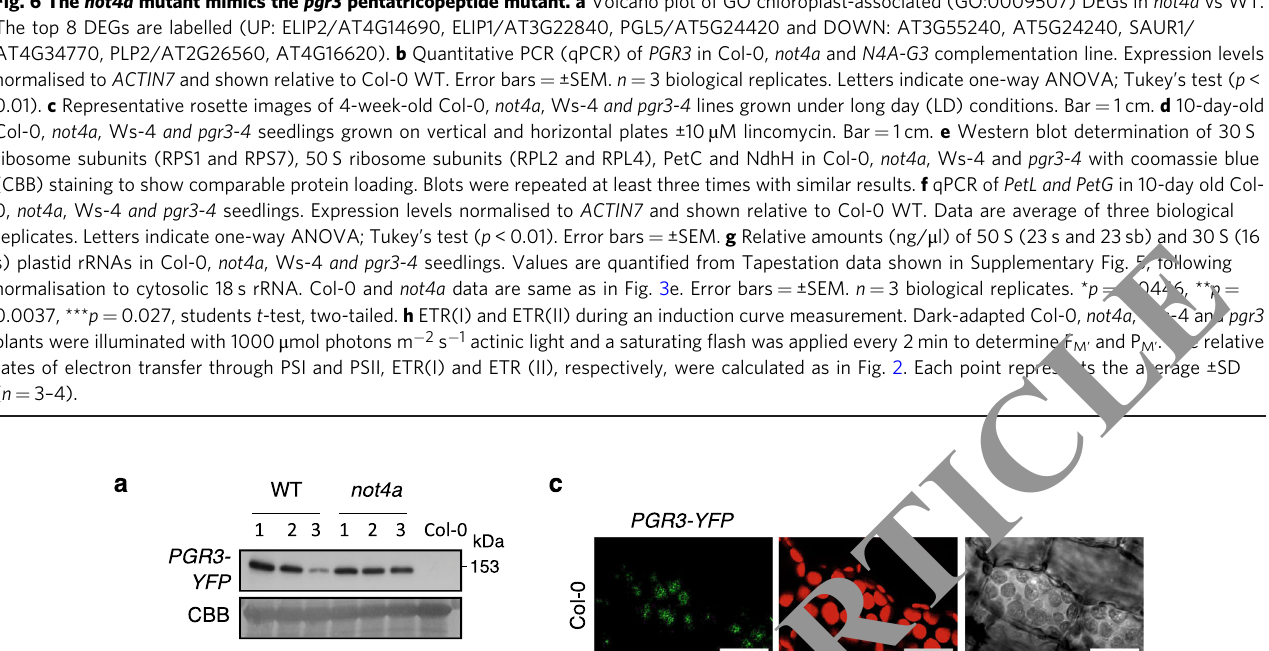
Fig. 6 The not4a mutant mimics the pgr3 pentatricopeptide mutant. a Volcano plot of GO chloroplast-associated (GO:0009507) DEGs in not4a vs WT. The top 8 DEGs are labelled (UP: ELIP2/AT4G14690, ELIP1/AT3G22840, PGL5/AT5G24420 and DOWN: AT3G55240, AT5G24240, SAUR1/ AT4G34770, PLP2/AT2G26560, AT4G16620). b Quantitative PCR (qPCR) of PGR3 in Col-0, not4a and N4A-G3 complementation line. Expression levels normalised to ACTIN7 and shown relative to Col-0 WT. Error bars = ±SEM. n = 3 biological replicates. Letters indicate one-way ANOVA; Tukey ’ s test ( p < 0.01). c Representative rosette images of 4-week-old Col-0, not4a , Ws-4 and pgr3-4 lines grown under long day (LD) conditions. Bar = 1 cm. d 10-day-old Col-0, not4a , Ws-4 and pgr3-4 seedlings grown on vertical and horizontal plates ±10 µ M lincomycin. Bar = 1 cm. e Western blot determination of 30 S ribosome subunits (RPS1 and RPS7), 50 S ribosome subunits (RPL2 and RPL4), PetC and NdhH in Col-0, not4a , Ws-4 and pgr3-4 with coomassie blue (CBB) staining to show comparable protein loading. Blots were repeated at least three times with similar results. f qPCR of PetL and PetG in 10-day old Col- 0, not4a , Ws-4 and pgr3-4 seedlings. Expression levels normalised to ACTIN7 and shown relative to Col-0 WT. Data are average of three biological replicates. Letters indicate one-way ANOVA; Tukey ’ s test ( p < 0.01). Error bars = ±SEM. g Relative amounts (ng/ μ l) of 50 S (23 s and 23 sb) and 30 S (16 s) plastid rRNAs in Col-0, not4a , Ws-4 and pgr3-4 seedlings. Values are quanti fi ed from Tapestation data shown in Supplementary Fig. 5, following normalisation to cytosolic 18 s rRNA. Col-0 and not4a data are same as in Fig. 3e. Error bars = ±SEM. n = 3 biological replicates. * p = 0.0446, ** p = 0.0037, *** p = 0.027, students t -test, two-tailed. h ETR(I) and ETR(II) during an induction curve measurement. Dark-adapted Col-0, not4a , Ws-4 and pgr3 plants were illuminated with 1000 μ mol photons m − 2 s − 1 actinic light and a saturating fl ash was applied every 2 min to determine F M ’ and P M ’ . The relative rates of electron transfer through PSI and PSII, ETR(I) and ETR (II), respectively, were calculated as in Fig. 2. Each point represents the average ±SD ( n = 3 – 4).